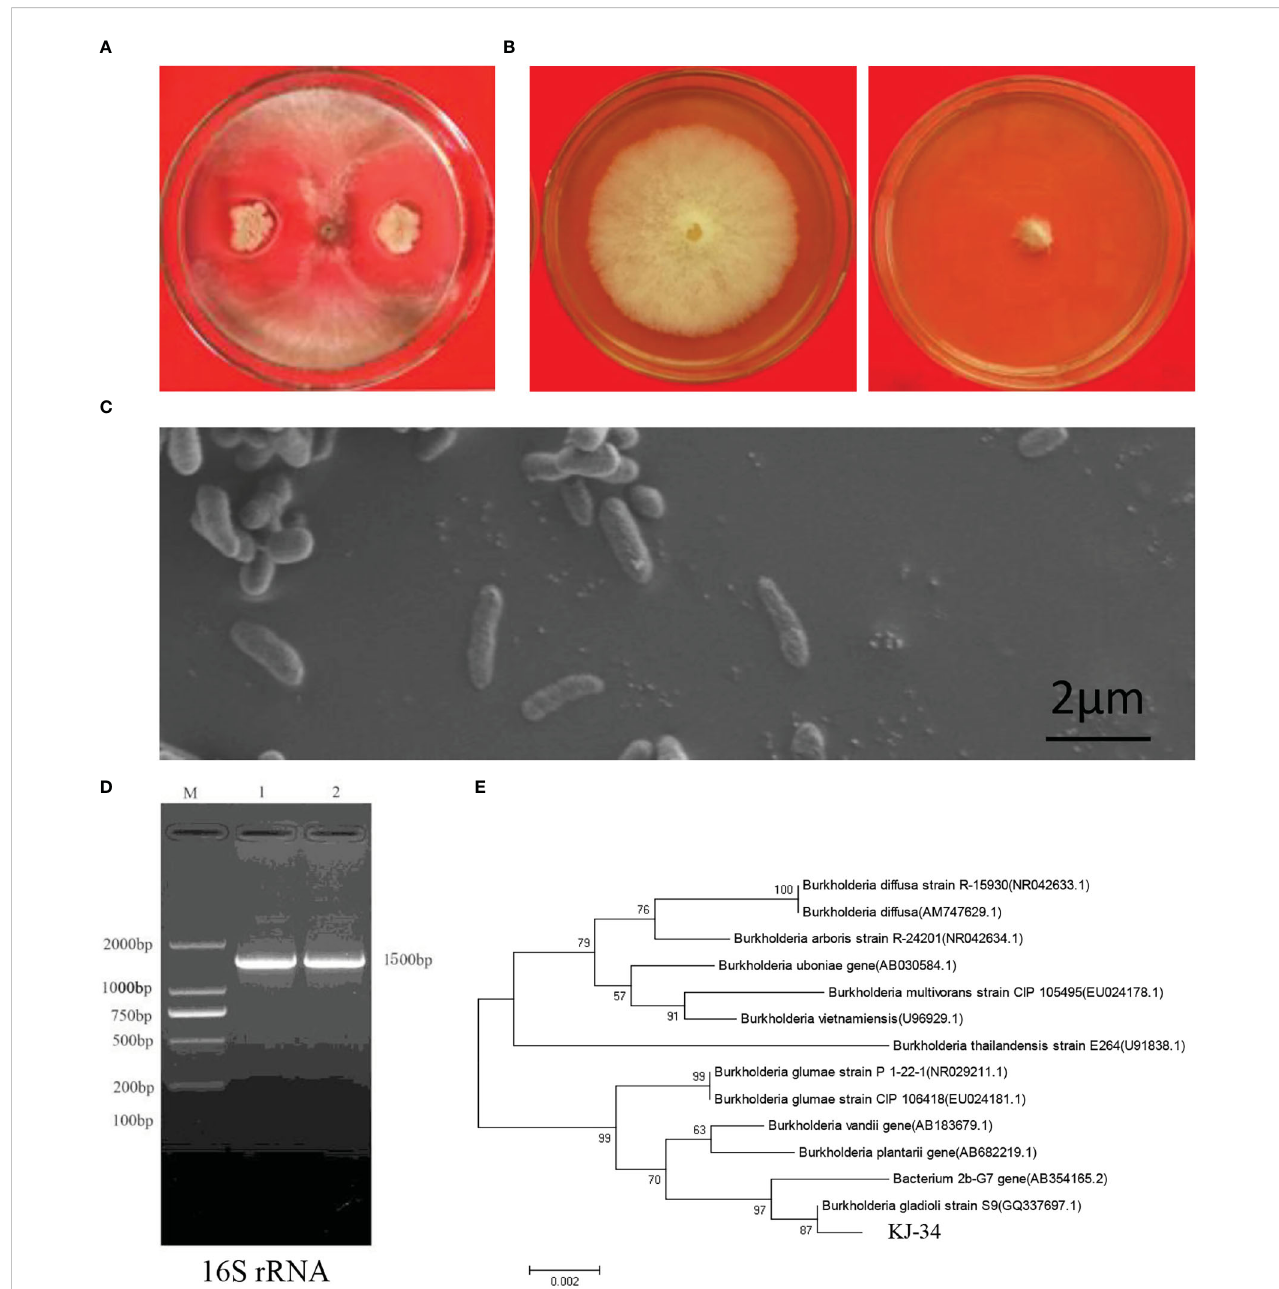
FIGURE 1 Identi fi cation of KJ-34. (A) Antagonistic inoculation of KJ-34 was applied to B. cinerea colonies grown on plates containing the solid medium PDA, and incubated at 28°C for 5 days, following which the colonies were photographed. (B) Inhibition of B. cinerea following treatment with KJ-34 shaking fl ask fermentation fi ltrate. (C) The bacterium was observed with a scanning electronic microscope (bar =2 m m). (D) 16S rRNA from KJ-34 was ampli fi ed by using the 27F/1,492 primer. (E) Theh phylogenetic tree of strain KJ-34 and its close relatives based on 16S rRNA gene sequencing. Dendrograms were generated by the neighbor-joining